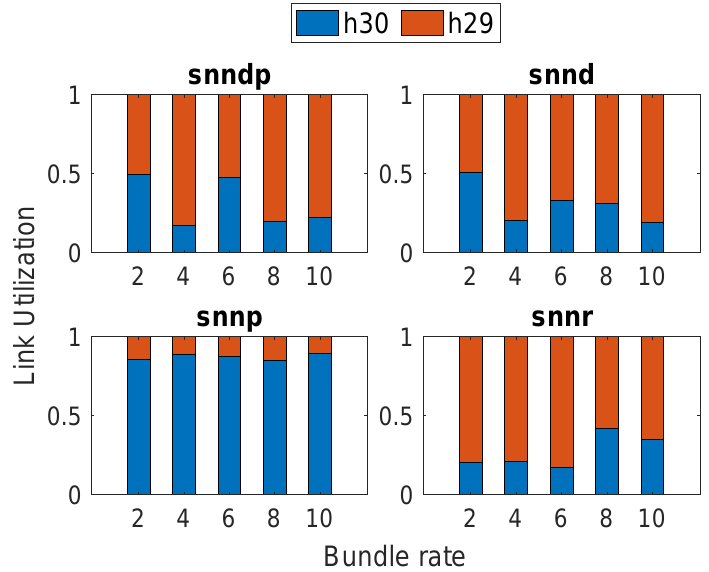
Figure 6. Link selection at Node h26: Scenario 2